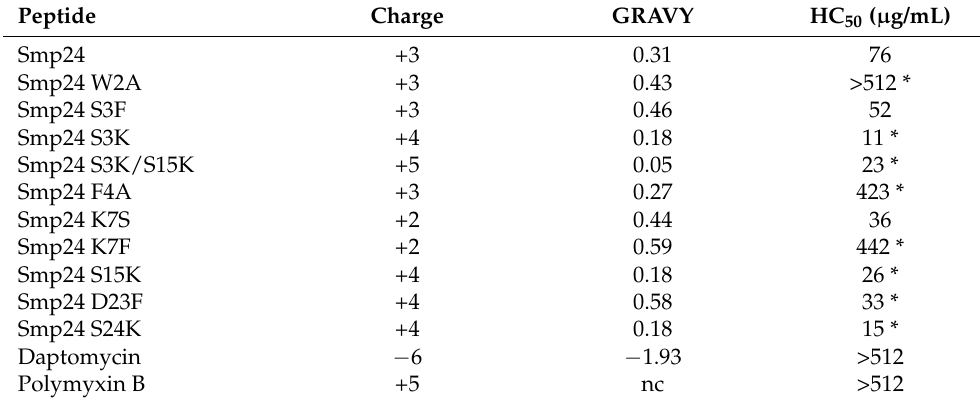
Table 3. Haemolytic activity of Smp24 and its derivatives. Statistical significance of the difference between Smp24 and its derivatives was determined by performing a Student’s T -test on the data. * denotes p -value < 0.05. nc denotes not calculable due to the mixed population of the two separate polymyxins.